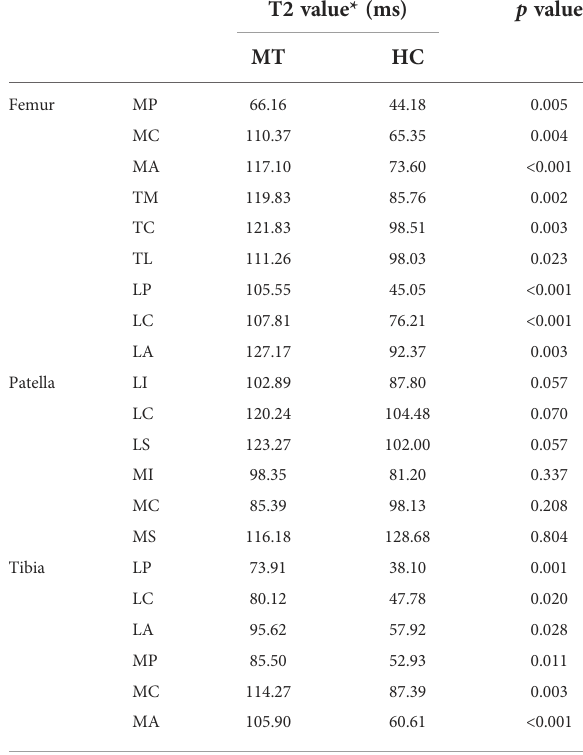
TABLE 2 Comparison of T2 values of the articular cartilage 21 subregions between the meniscus tear group and the healthy control